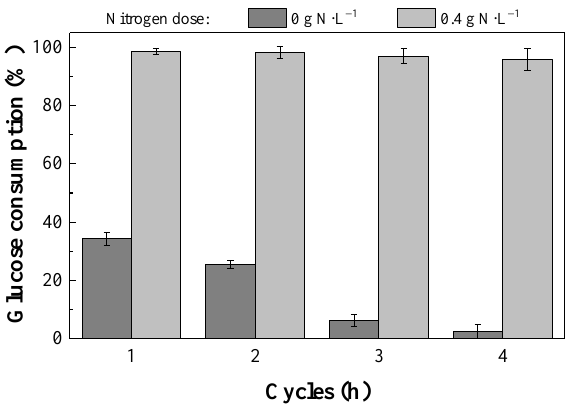
Figure 3. Yeast cell recycling in continuous co-fermentation using four S. cerevisiae strains (CLQCA-INT-001, CLQCA-INT-005, CLQCA-10-099 and UCLM 325), without a nitrogen source and with media supplementation (0.4 g N · L − 1 from yeast hydrolysate). Error bars represent the standard deviation across three